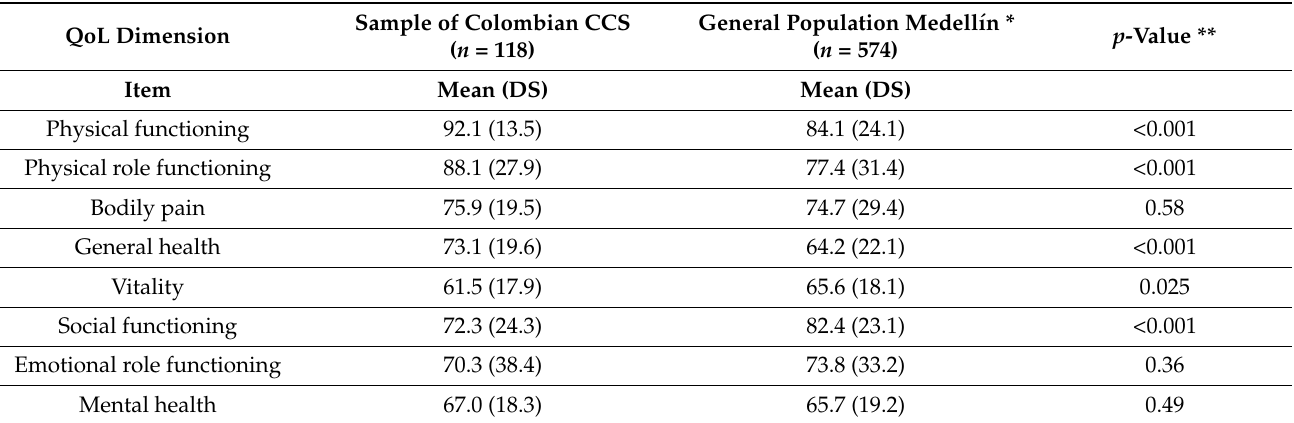
Table 5. Mean scores of the scales of the SF-36 questionnaire according to sex: comparison with the general population of Medell í